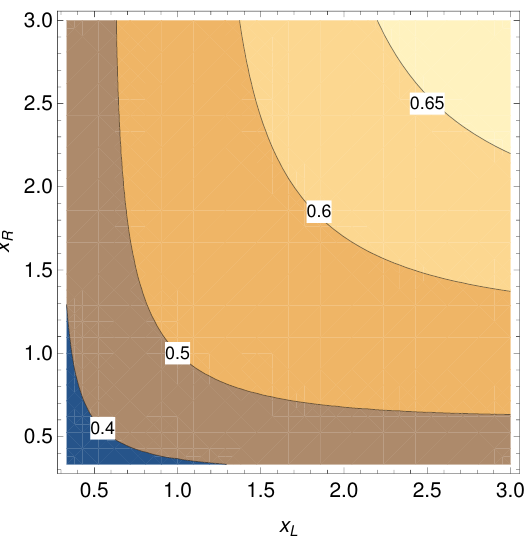
Figure 12 . Dependence of function g ( x L ; x R ) of eq. (5.15) on the splitting between the slepton and bino